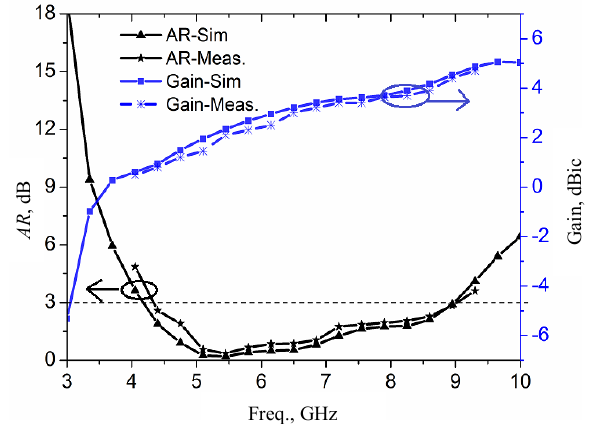
Fig. 18. Measured and simulated AR and gain of fabricated